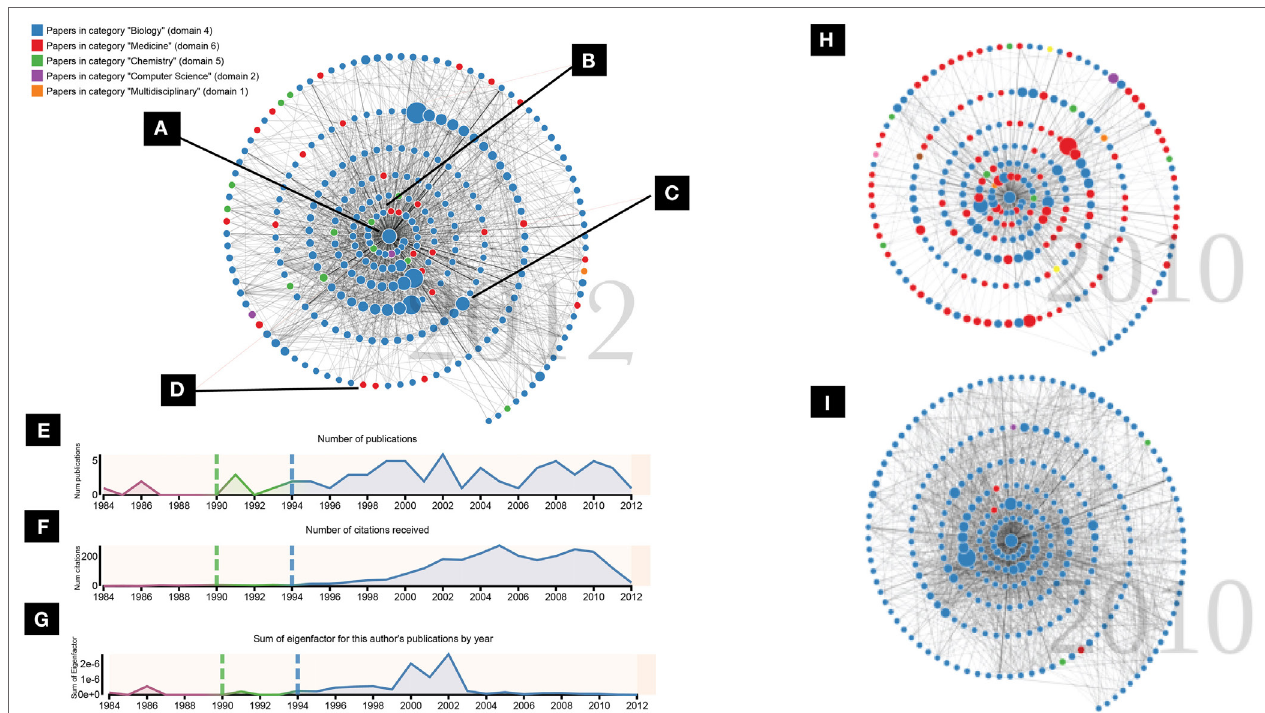
FigUre 2 | Top Left: (a) The center node represents all publications of a particular scholar. (B) Nodes that appear around the center represent publications that cited work by this scholar. (c) The size of the nodes show a citation-based indicator (Eigenfactor) of how influential that paper has been. (D) Colors show different fields to which the papers apply. Bottom Left: Integrated timeline charts below the network visualization. (e) Number of publications by the central scholar by year. (F) Number of citations received by the central scholar by year. (g) Sum of the Eigenfactor for all of the publications published by the central author in each year. Colors show the periods before, during, and after funding from the Pew program. Right side: comparing the densities of two different graphs. (h) A sparse graph that shows a diffuse influence across fields (i.e., interdisciplinary influence). (i) A dense graph that shows a close-knit citation community within one